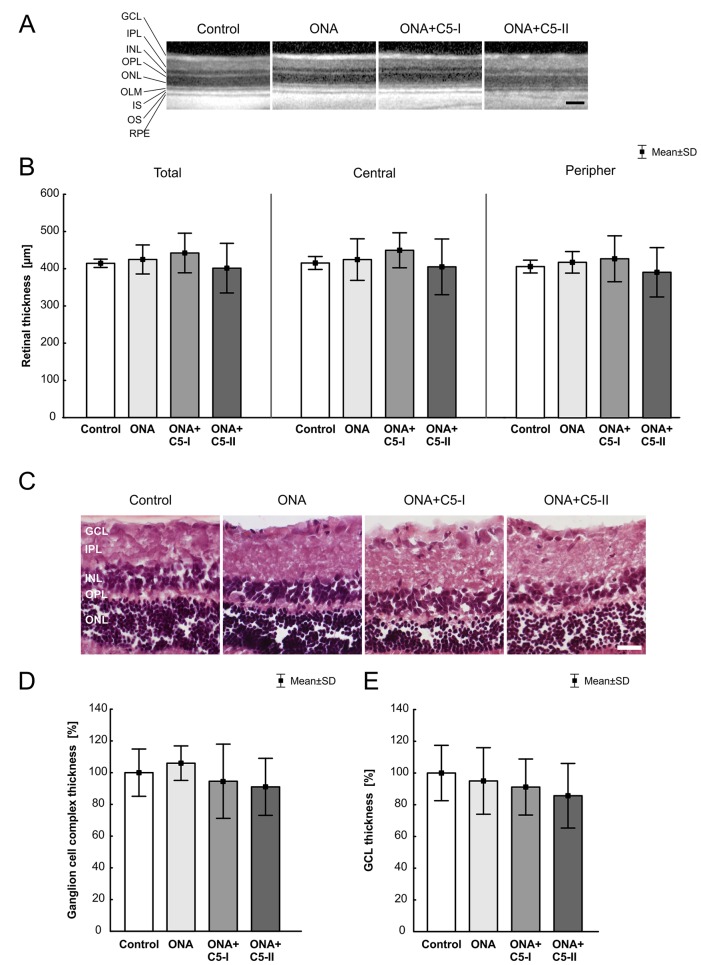
Unchanged retinal thickness. (A) After 6 weeks, SD-OCT pictures of all groups showed no visual abnormalities. (B) There were no significant differences in the thickness of the total, central and peripheral retina between all groups. (C) H&E stained retinal cross-sections of all groups displayed an intact retinal morphology. (D) No alterations in the thickness of the ganglion cell complex between all groups were observable. (E) Also, the average thickness of the GCL was similar in all four groups. GCL, ganglion cell layer; IPL, inner plexiform layer; INL, inner nuclear layer; OPL, outer plexiform layer; ONL, outer nuclear layer; IS, inner segment; OS, outer segment; RPE, retinal pigment epithelium. Values are mean ± SD. Scale bars = (A) 200 µm, (C) 50 µm.